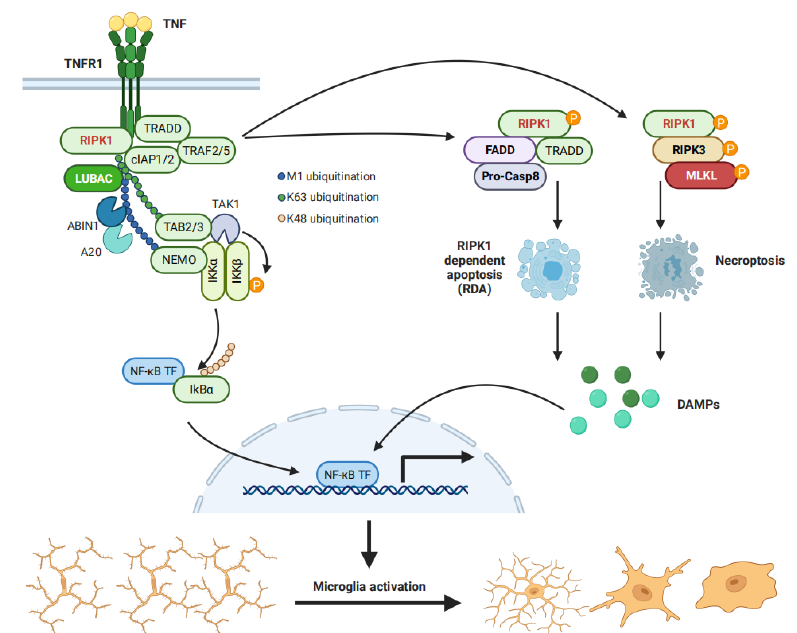
Figure 1. TNFR1 activation promotes NF- κ B activation via cell-autonomous and non-autonomous mechanisms. TNF binds to TNFR1 to form an intracellular protein complex that promotes the activation of NF- κ B via the scaffold function of RIPK1 ( Left ). The kinase activity of RIPK1 mediates RIPK1-dependent apoptosis (RDA) when cFLIPL expression induced by NF- κ B is comprised, while activated RIPK1 promotes necroptosis when active caspases are inhibited ( Right ). Both RDA and necroptosis cause the release of damage-associated molecular patterns (DAMPs) to activate the NF- κ B pathway via non-cell autonomous mechanisms.